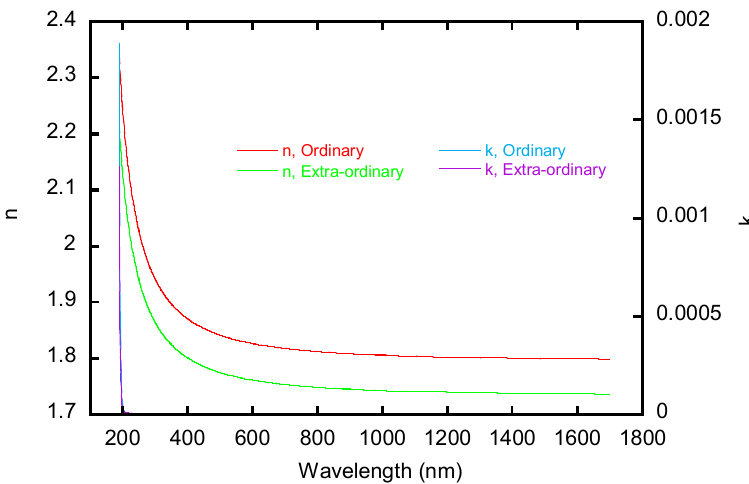
Figure 13. Anisotropic optical constants obtained by the model fitting.